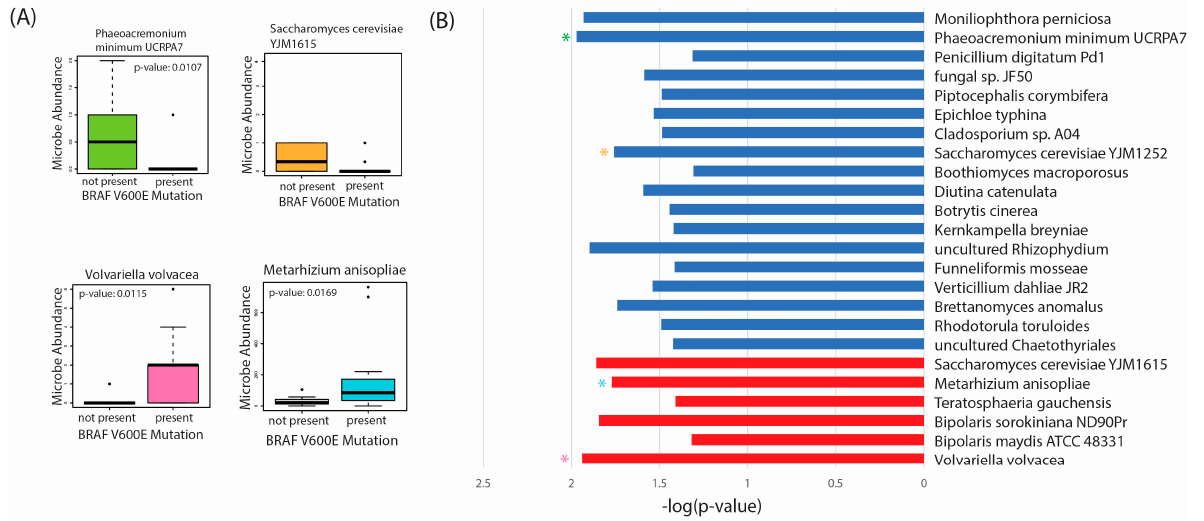
Figure 6. Differential abundance analysis of fungal species according to BRAF V600E mutation status in PTC patients. Significantly differentially abundant microbes were defined by a p -value of < 0.05 and a log-fold change (FC) > 1. ( A ) Selected boxplots of differentially abundant microbes in patients with the BRAF V600E mutation vs patients with no mutation. ( B ) − log( p -value) of sinificantly dysregulated microbes according BRAF V600E mutation status. A total of 18 fungal species, represented in blue were overabundant in BRAF V600-negative patients, while 6 fungal species, represented in red, were overabundant in BRAF V600-positive patients. Asterisks represent corresponding boxplots, according to color, represented in Part A.